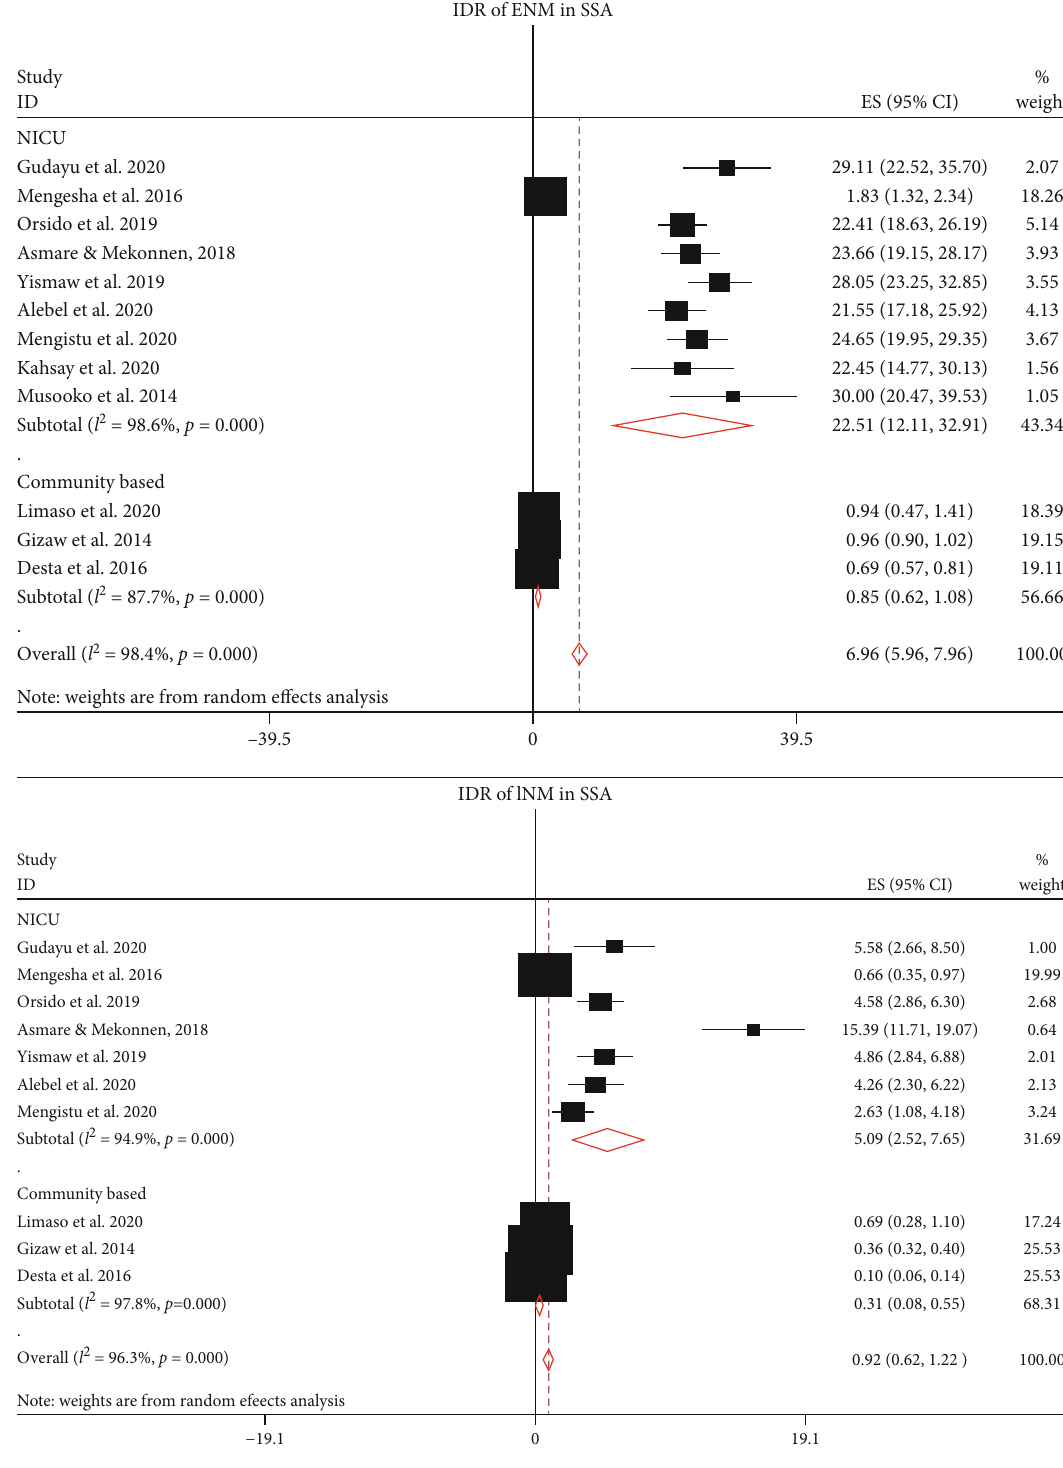
Figure 3: The IDR of early neonatal mortality (ENM) and late neonatal mortality (LNM) in